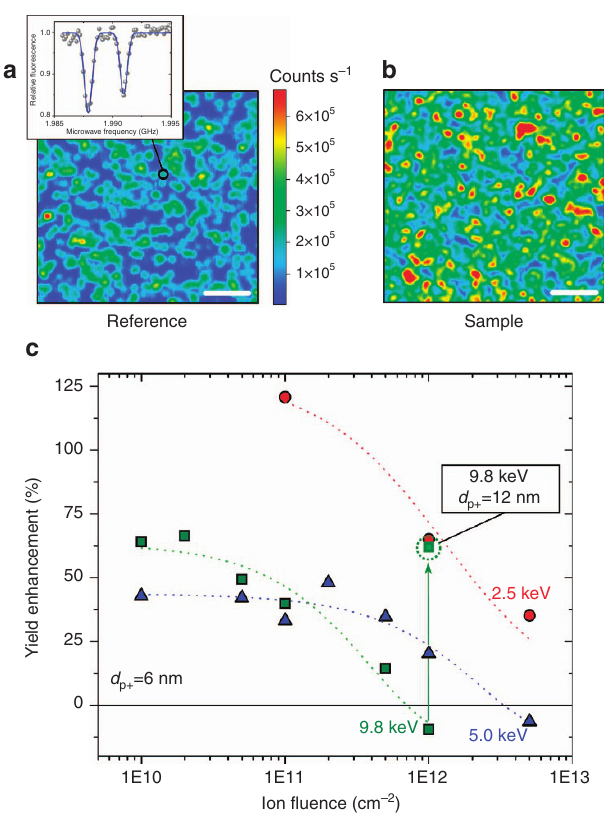
Figure 2 | NV centres by nitrogen implantation across planar p þ –i junction structure. ( a , b ) Two-dimensional confocal maps of NV centres comparing the ‘Reference’ and ‘Sample’ areas, respectively, after ion implantation (5keV 15 N þ , 10 10 cm (cid:2) 2 fluence), thermal annealing and final etch (7nm). The inset shows a typical optically detected magnetic resonance spectrum of the implantation-induced NVcentres ( 15 N hyperfine splitting). Scale bars are 3 m m. ( c ) Enhancement in the formation yield of NV centres as a function of nitrogen ion fluence for three different implantation energies (2.5, 5.0 and 9.8keV). The thickness of the boron- doped layer ( d p þ ) is 6nm. The highlighted point corresponds to the yield enhancement for nitrogen implantation with 9.8keV of energy in another diamond with a thicker ( d p þ ¼ 12nm) boron-doped layer (see text). The dashed-lines are guides to the eye. Horizontal error bars are negligible, whereas vertical error bars are in the range o ± 10% (not shown for